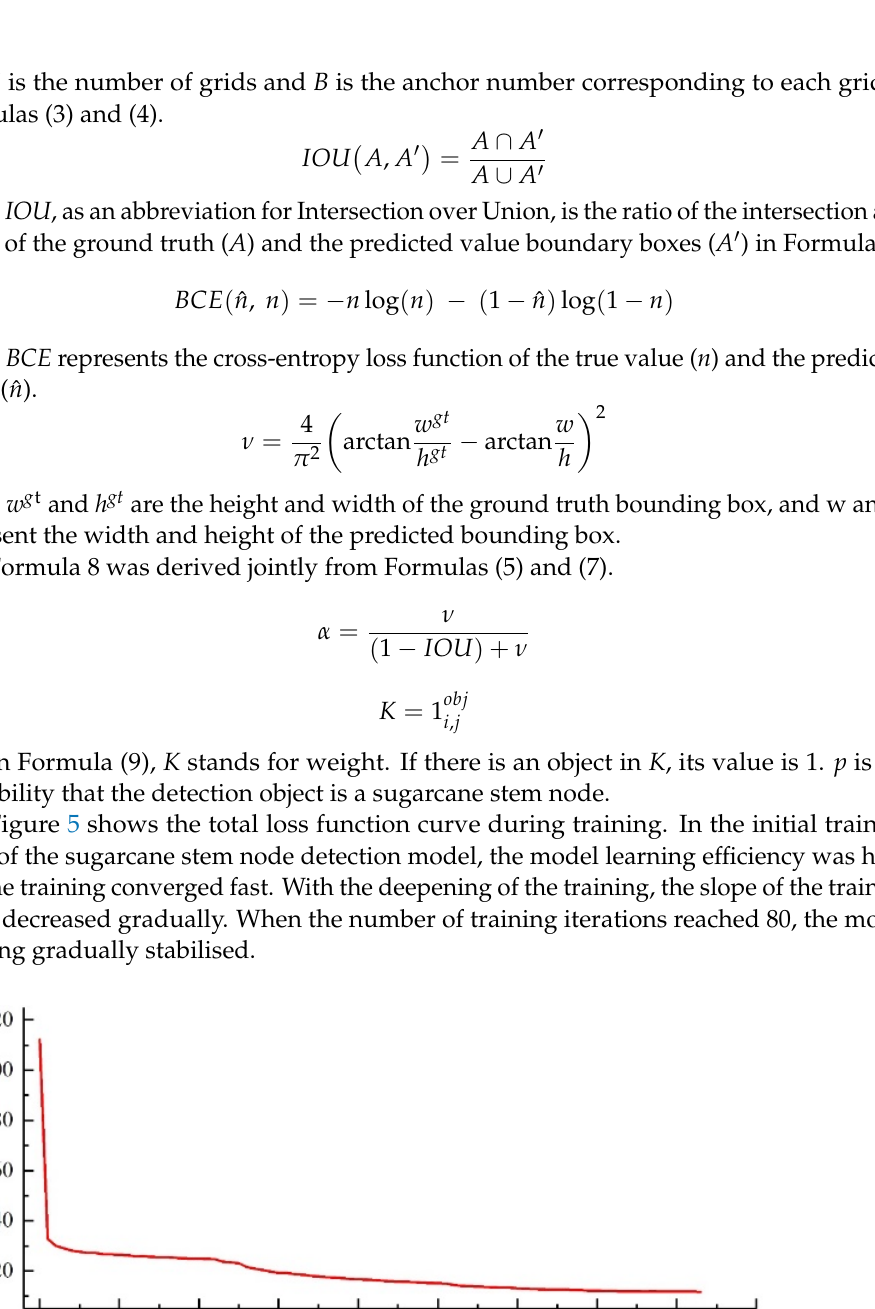
Figure 5. Total loss function curve of model training. The detection result of sugarcane stem nodes based on YOLO v4 is shown in Figure 6. In addition to the images processed by random colours, the algorithm can detect the cane stem node from the original image and three kinds of data-enhanced images, which proved that the algorithm had a high accuracy. In Figure 6e, the lowest sugarcane stem node was over-exposed after random colour processing, so it could not be